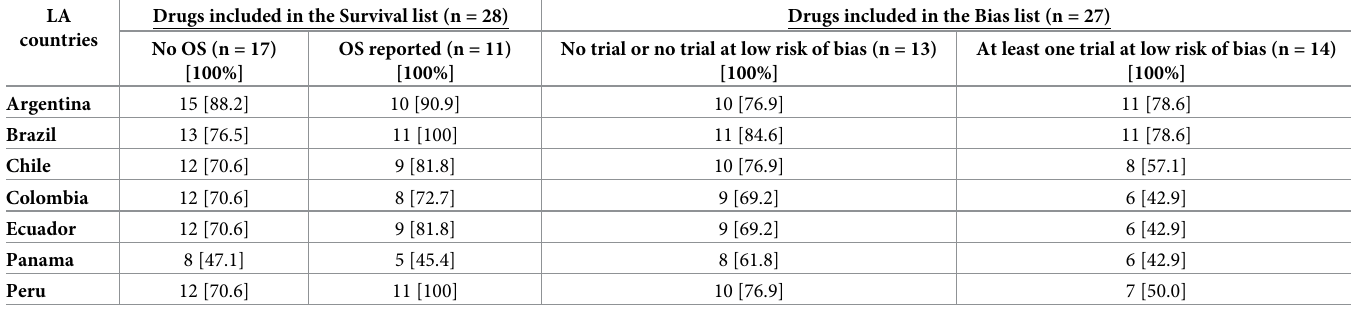
Table 1. Summary of marketing authorizations per LA country according to the availability of OS data and risk of bias assessment of the cancer drugs approved by EMA between 2009–2016. LA Drugs included in the Survival list (n = 28) Drugs included in the Bias list (n = countries